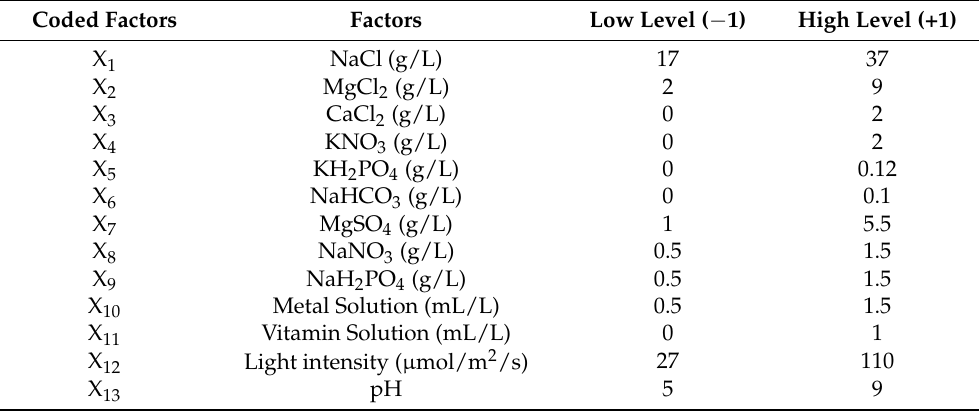
Table 2. Plackett–Burman experimental design for the evaluation of 13 independent variables on PE